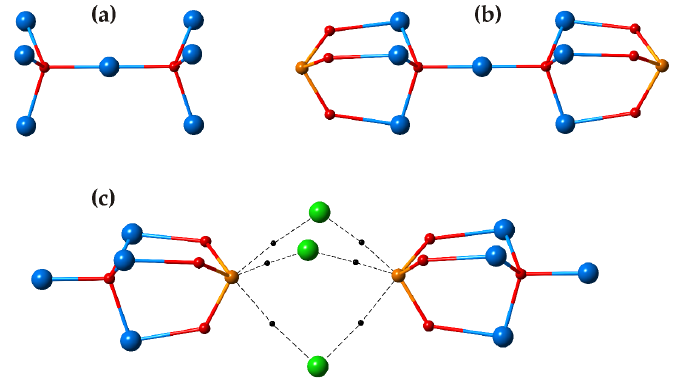
Figure 8. The [O 2 Cu 7 ] dimer of two corner-sharing (OCu 4 ) tetrahedra in the crystal structure of burnsite ( a ) and its coordination by two (SeO 3 ) groups ( b ). The atomic configuration inside the metal-oxide framework cavity showing the orientation of Se–Cl closed-shell interactions. ( c ) Legend as in Figure